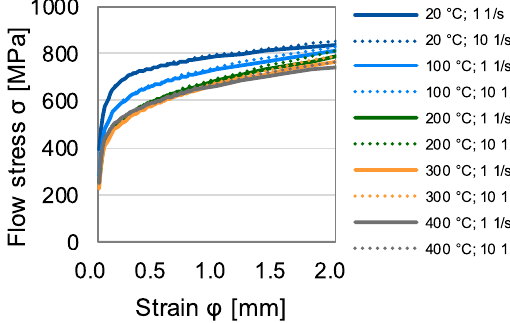
Fig. 4. Flow curves of case-hardening steel SAE 5115 at different strain rates and temperatures (extrapolated through Ludwik approach).